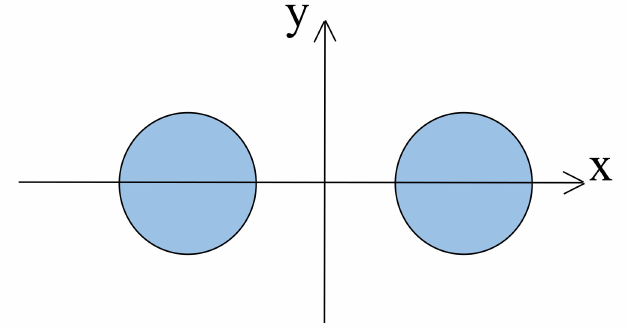
Figure 7. Two-wire transmission